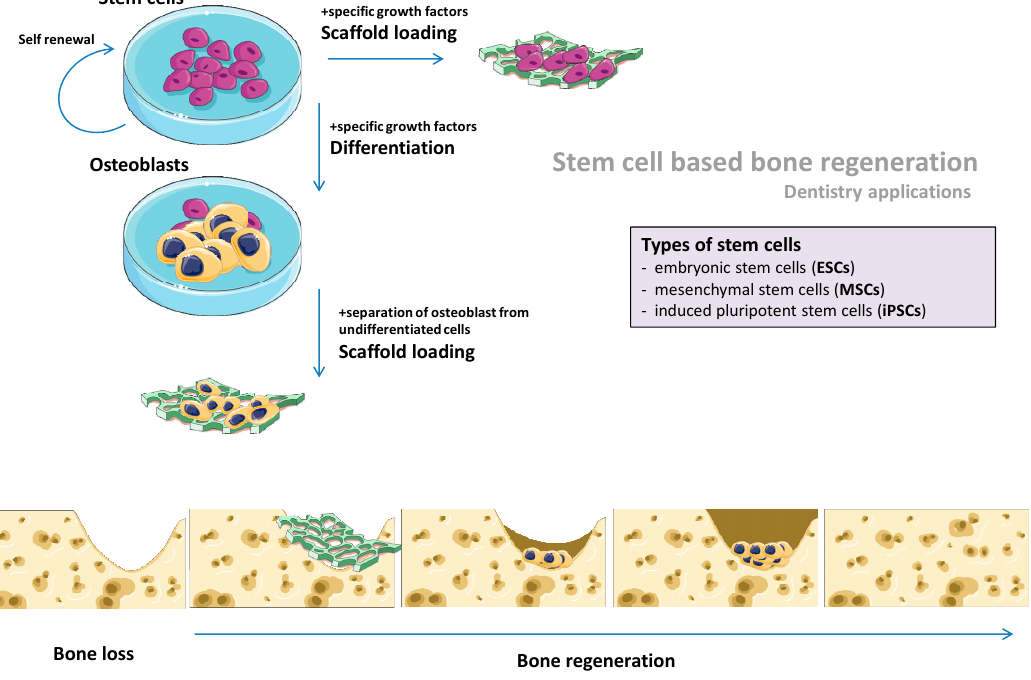
Figure 1. Stem-cell based bone regeneration. Stem cells have the capacity of self-renewal and they can be propagated ex vivo; however, in the presence of specific growth factors with osteogenic potential, the cells differentiate toward osteoblast with the capacity of bone regeneration. For regenerative purposes the cells (undifferentiated or differentiated cells) are embodied in scaffold structures of various biocompatible materials that are further implanted within the affected area.